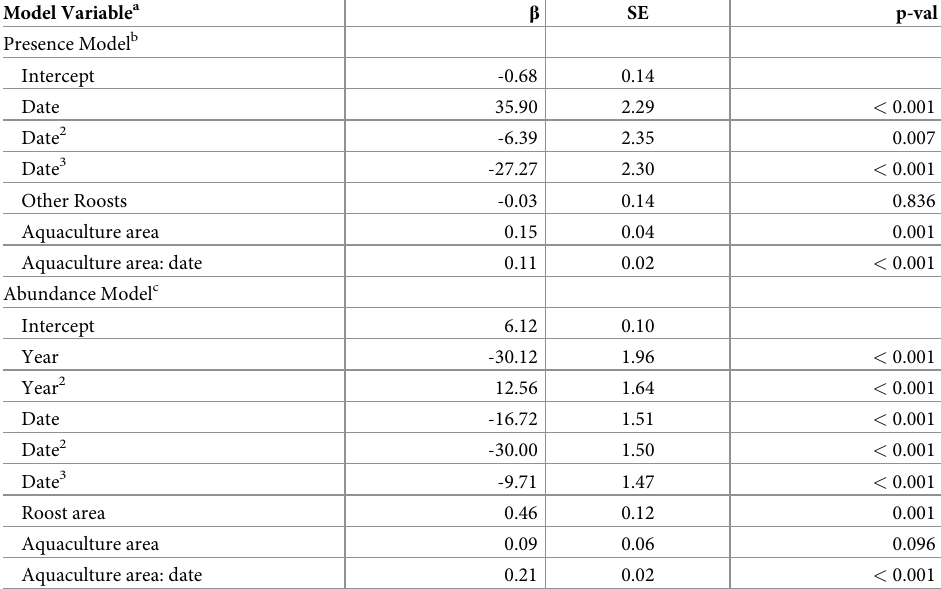
Table 1. Parameter estimates for standardized variables modeled for cormorant presence and positive count val- ues at roosting locations in the Mississippi Delta. The presence model was done using generalized linear mixed effects model with a binomial distribution based on cormorant presenece and absence. The count model was done using a generalized linear mixed effects model with negative binomial regression on counts greater than zero. For both models roost ID was set as a random effect. Data was collected at multiple time points over the winter months (Octo- ber–April) from 1996–2010, and